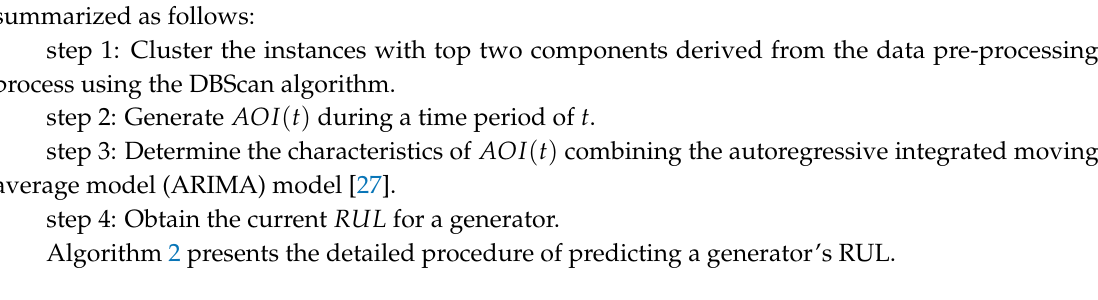
Algorithm 2 Prediction ( I , α , β , τ